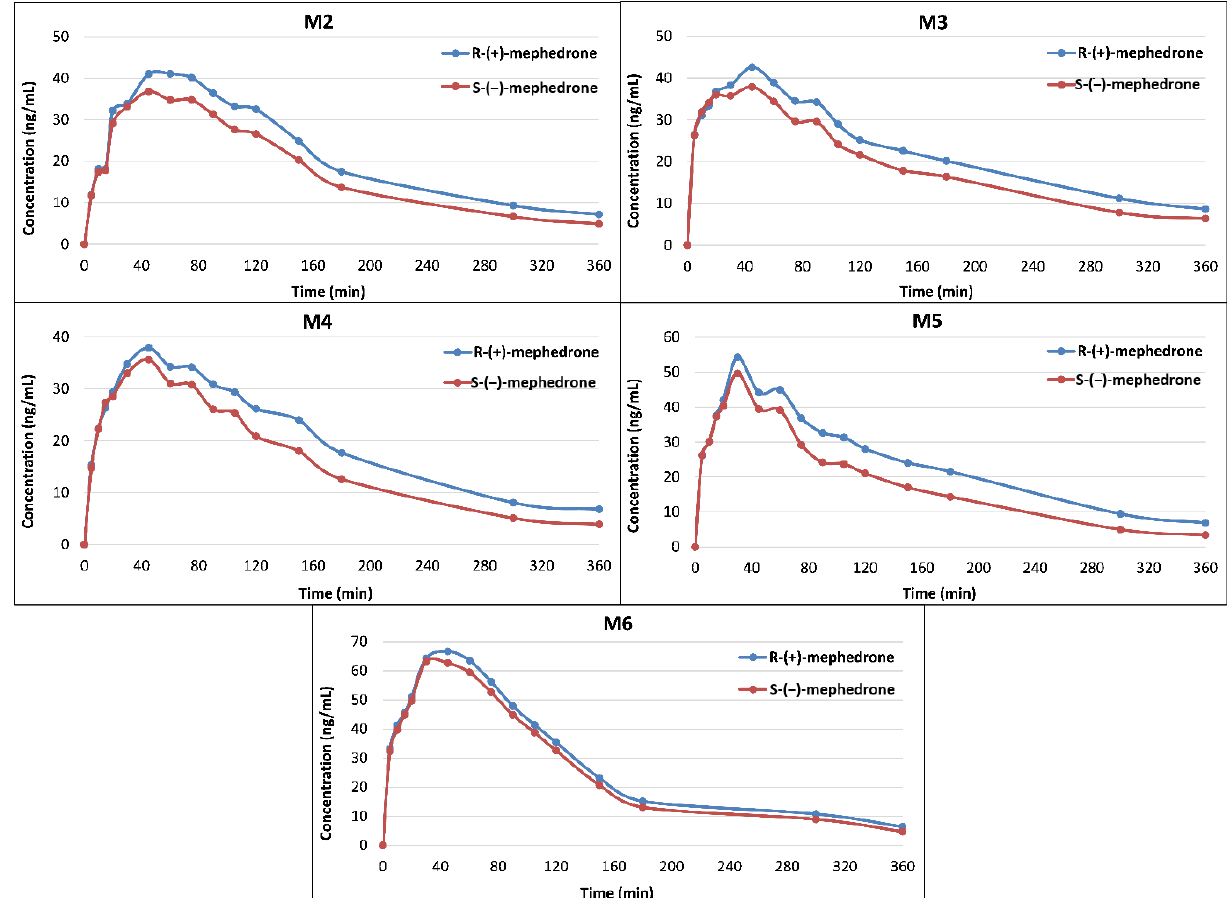
Figure 3. Concentrations of R-(+)-mephedrone and S-(−)-mephedrone in whole blood in five participants (M2–M6).